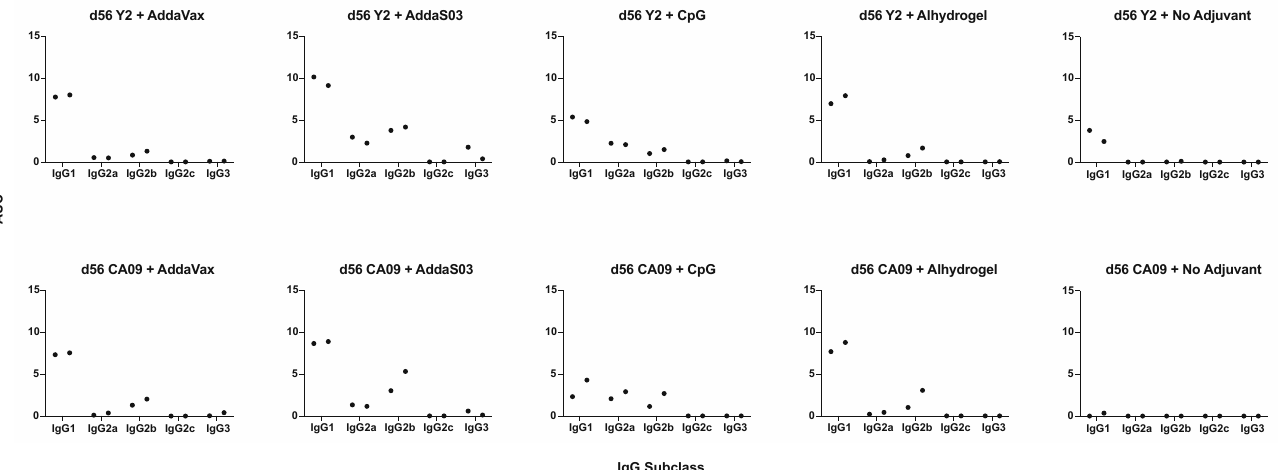
Figure 2. Th1/Th2 ELISAs at d56 after adjuvanted vaccination with Y2 and CA09 HAs. IgG subclass- specific serum titers, determined by ELISA, are shown for male and female pooled sera at d56 as AUC values. Coating antigens were the same HA as used for vaccination, The left point for each IgG subclass corresponds to male mice serum titers and the right point to female mouse serum titers. A minimum baseline absorbance at 405 nm of 0.3 was considered a positive binding signal.